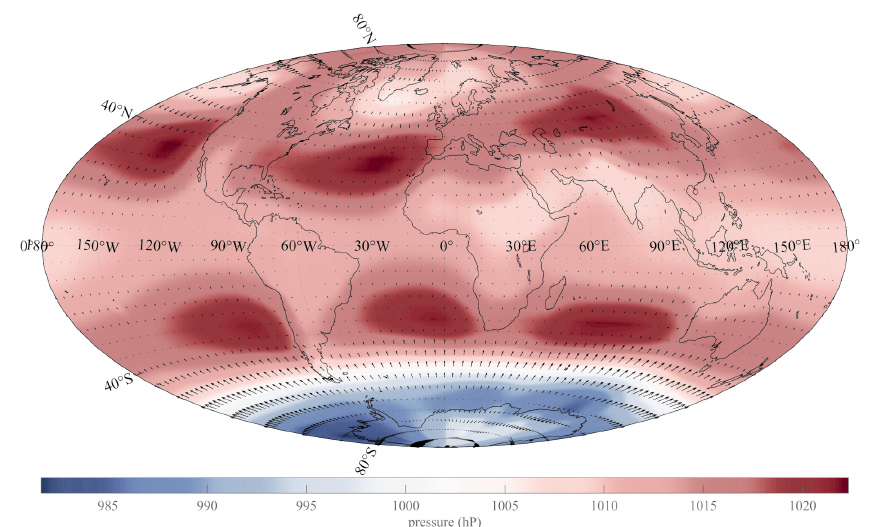
Figure 1. Mean pressure at sea level from 1850 to 2020 ( SLP ) (Hammer–Aitoff projection). Winds are proportional to the space derivative of pressure (Figure 2, which is the map most people are familiar with), and thus in space-phase quadrature with pressure features. The space derivative is a high-pass operator which exacerbates discontinuities and promotes oscillations one order higher than the causative features. Figure 2 shows how winds (the gradients of pressure) are slowed or suppressed by continental masses; additionally, the red and blue “anomalies” are often paired, which reminds one of Laplace’s statement that the vector sum of winds must be close to zero at any instant.